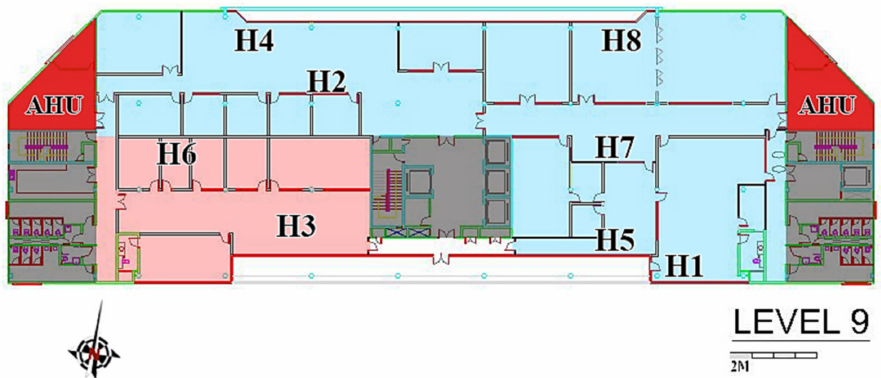
Figure 4. Typical floor (9th) of UM Chancellery Building and distribution of data loggers. There are two air-conditioned offices on this floor in light blue and pink. HOBO data loggers were located at H1–H8 (close to the curtain walls and deep inside the offices). AHU is the air-handling